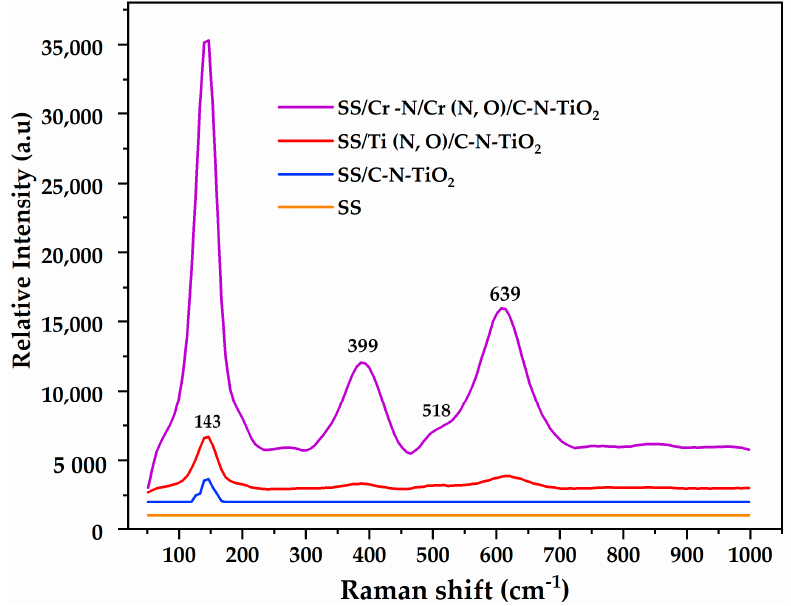
Figure 5. Raman analysis of C-N-TiO 2 coated films pyrolysed at 350 °C, a ramping rate of 50 °C/min for 105 min. Table 2. Particle sizes of C-N-TiO 2 coated on SS, SS/Ti (N, O) and SS/Cr-N/Cr (N, O) anticorrosion meshes calculated from XRD analysis using the Scherrer equation (n = 2). Photo Catalysts.